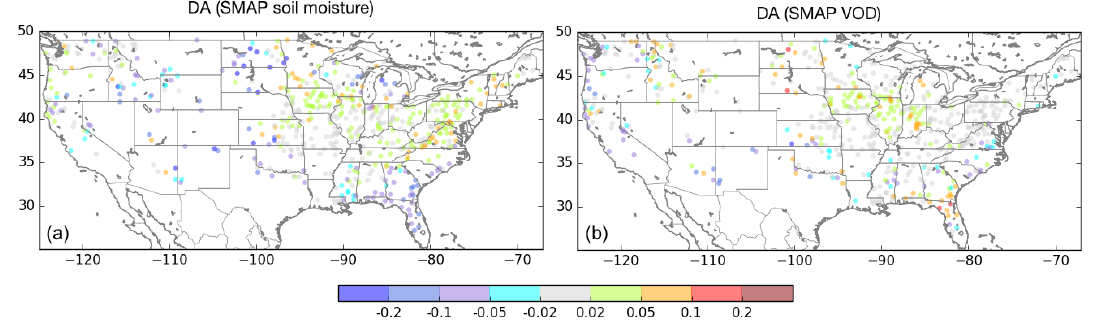
Figure 10. Improvements in streamflow NSE shown as NIC using the USGS daily streamflow observations as the reference for SMAP soil moisture DA (a) and SMAP VOD DA (b)